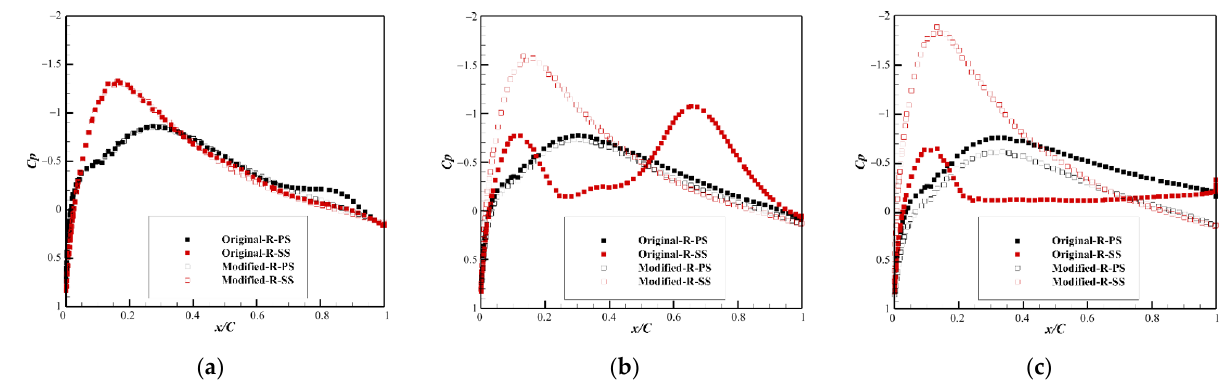
Figure 21. C p distributions on right vertical tail part of the original and modified models: β = ( a ) 0°, ( b ) 2°, and ( c ) 4°.